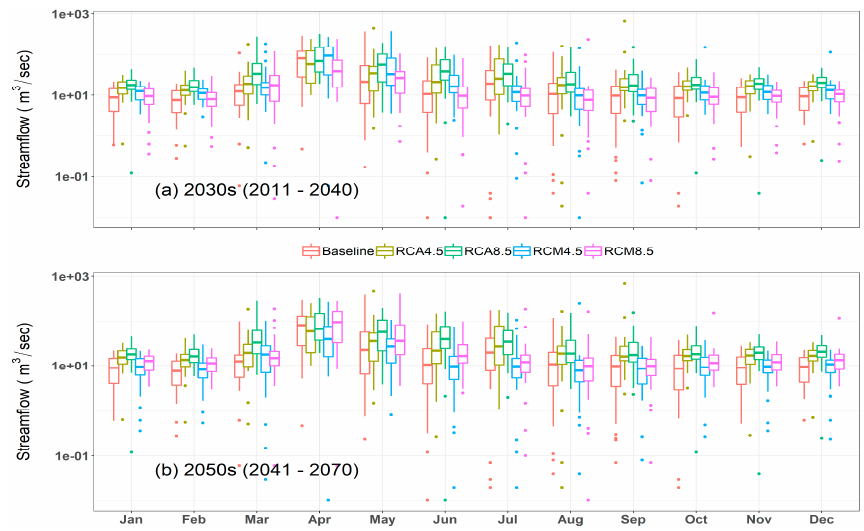
Figure 7. Average projected mean monthly streamflow for the ( a ) 2030s and ( b ) 2050s under RCP4.5 and RCP8.5 along with the baseline simulation (1988–2017). Whiskers are 1.5 times the interquartile range.